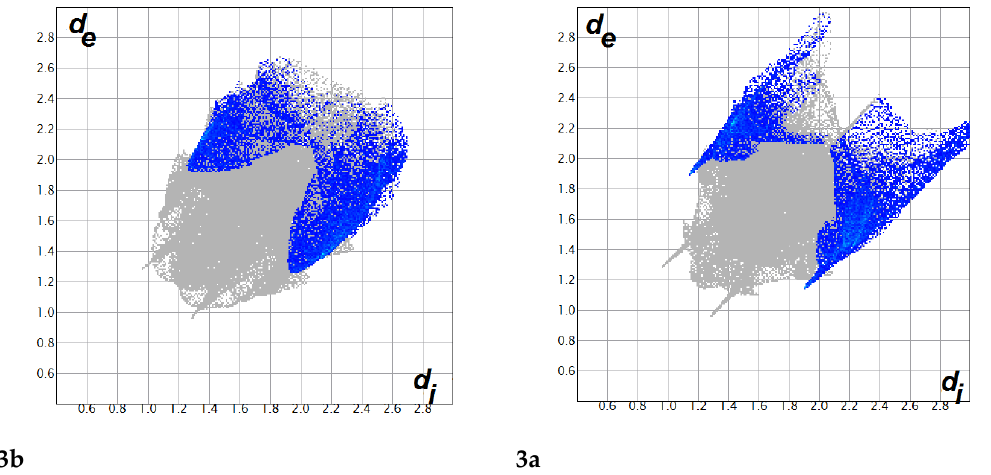
the longest in 3d . and